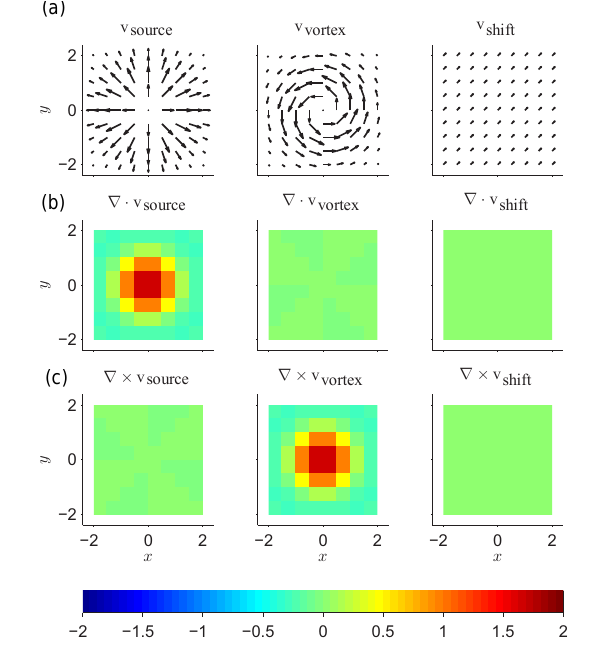
Figure 1. Synthetic input vector field terms (a) , the corresponding divergence (b) and curl (c) , depicted for field data with a grid size of δs = 1 / 2.